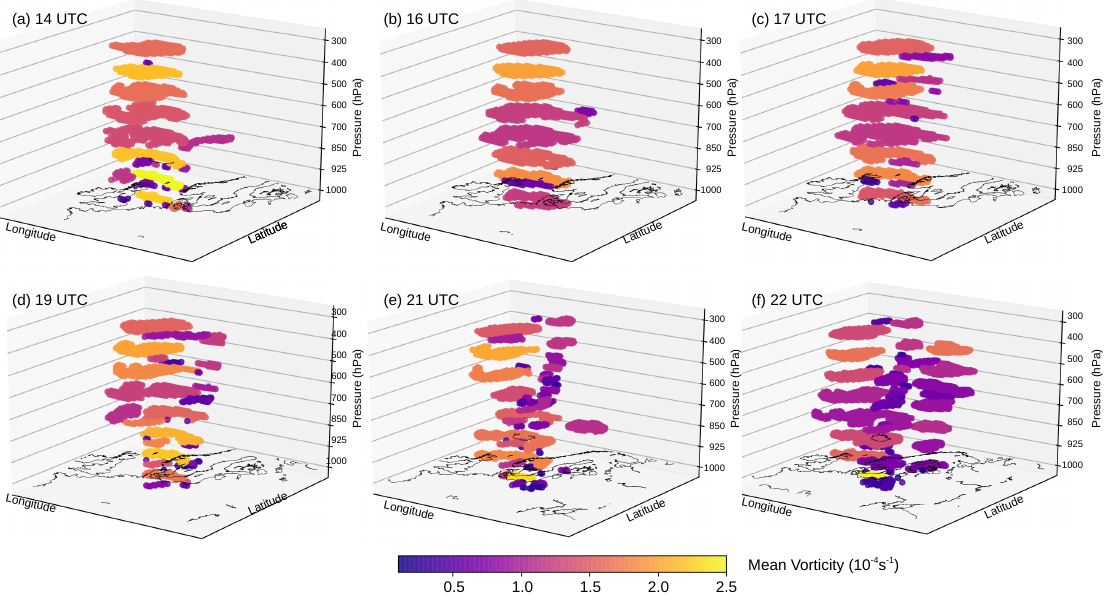
Figure 11. Three-dimensionally overlaid mean vorticity (in 10 − 4 s − 1 ) fields computed from CFSR data for different time steps. The domain moves and broadens with Kyrill’s circulation center and effective radius derived from NCEP data. Only vortices inside this effective radius are